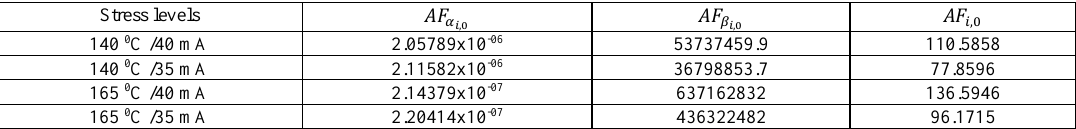
Table 3. Acceleration factors of parameters for different stress